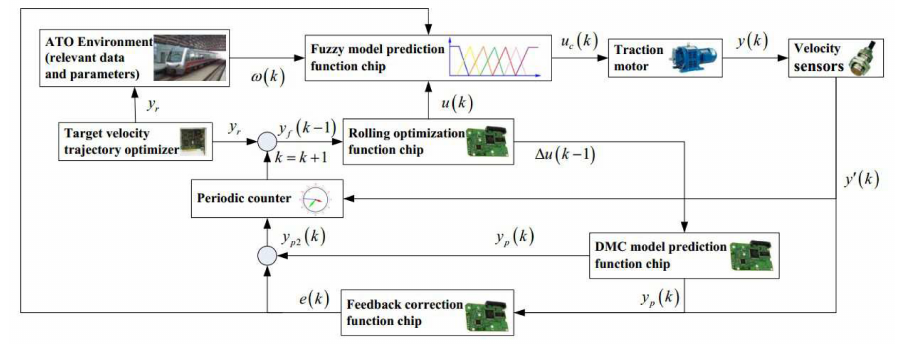
Figure 26. Schematic diagram of the Fuzzy Dynamic Matrix Control (DMC) Model Predictive Controller (MPC) proposed in [44] for automatic train